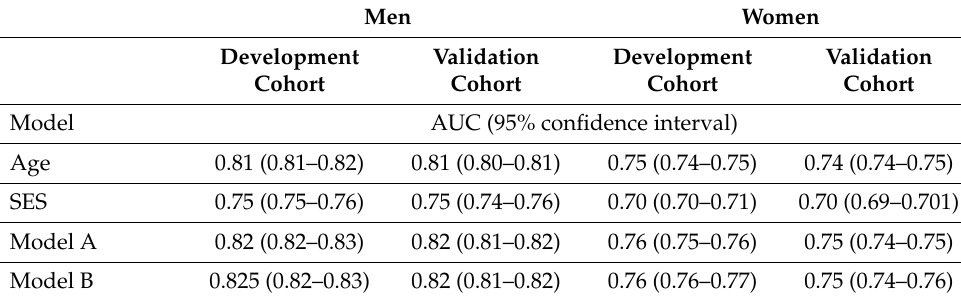
Table 4. Comparison of AUCs obtained for different prediction